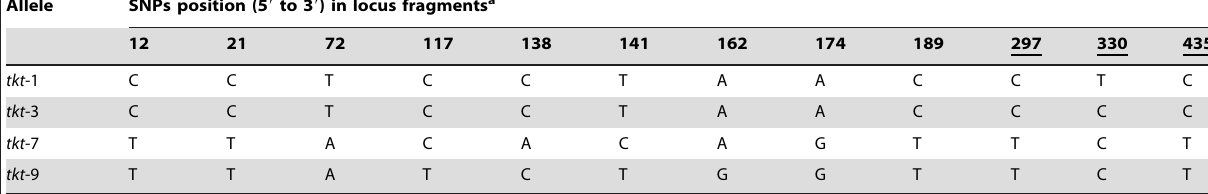
Table 4. SNPs in tkt locus fragments.